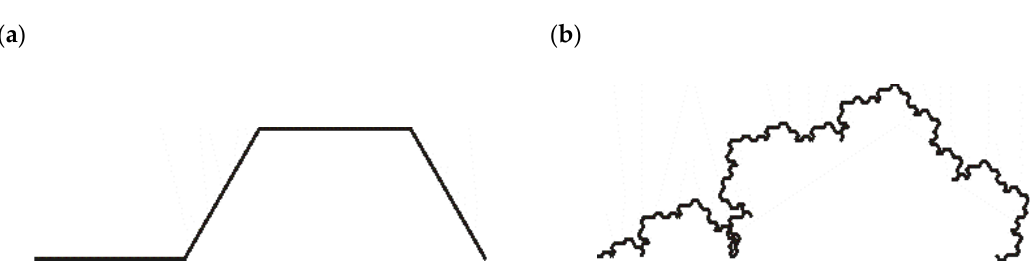
( b ) Figure 4. Koch curve in the fourth formation step ( a ) and the “pattern” of its formation—generator ( b ). As follows from the very nature of the fractal geometry, the actual formation called a fractal of a very complicated shape can be described with a simple recursive formula or a graphical rule based on initiator and generator. For example, Mandelbrot set, which is a set of all the possible Julia sets, of an infinitely large number of details, is described by a single line recursive formula. Koch curve, on the other hand, is created by substituting the initiator which is a segment by a generator shown in Figure 4b. A generator imperatively requires each strip/segment to be divided into three parts, and the middle part to be replaced by the sides of an equilateral triangle. This is repeated ad infinitum. A similar approach should be adopted to the problem of searching for a formula for the development of a model fracture, in, for instance, metakaolinite modified concrete. Looking for a formula in this case is the same as looking for a relevant generator. It should, however, be remembered that the generator itself cannot be identified with the fracture